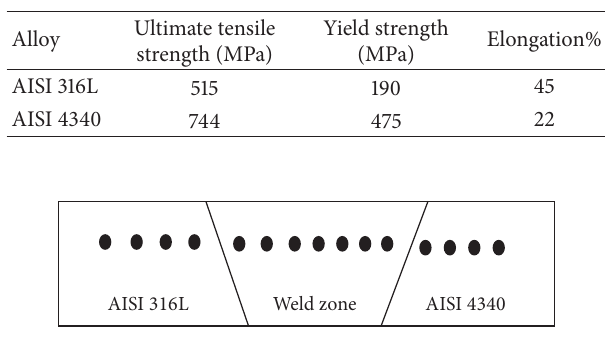
Figure 3: The schematic microhardness